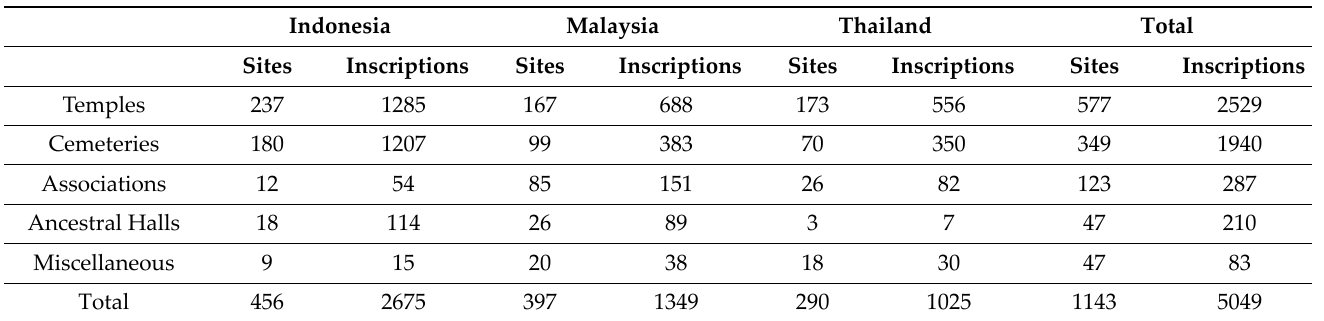
Table 4. Wolfgang Franke’s Chinese Epigraphy of SEA.